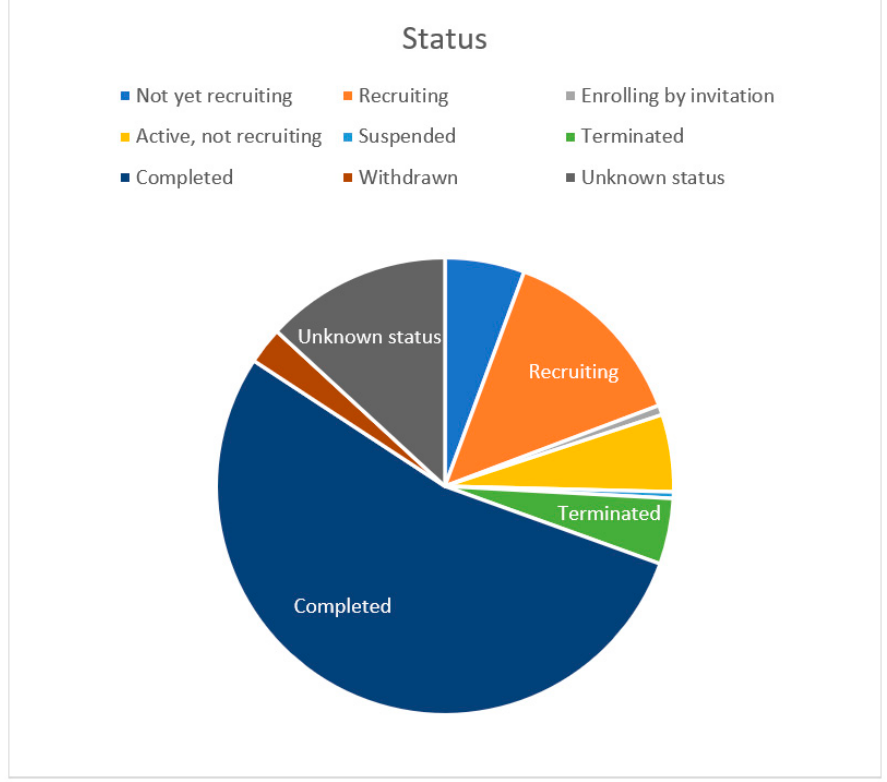
Figure 1. Status of registered studies for “Osteoarthritis, Knee”.